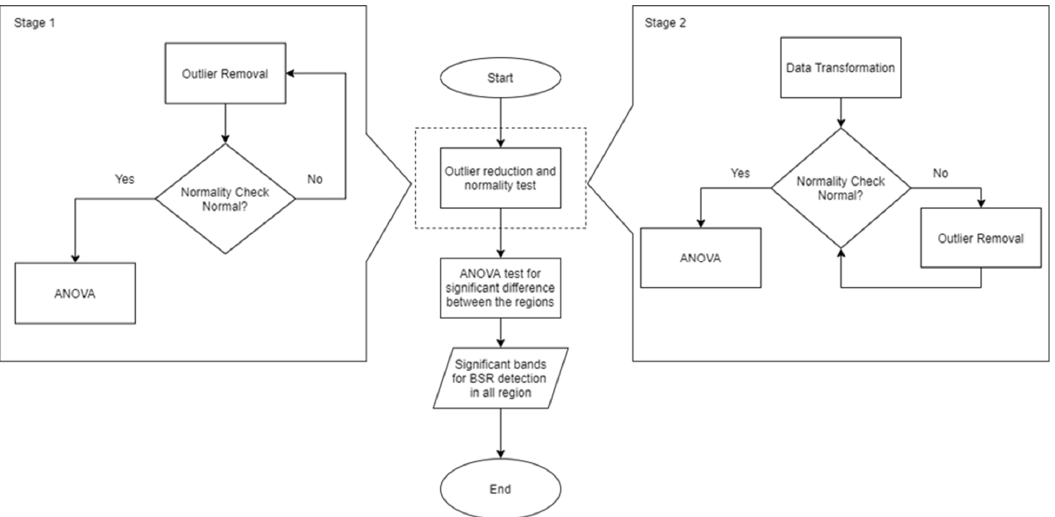
Figure 3. Flowchart of normality check and outlier removal .